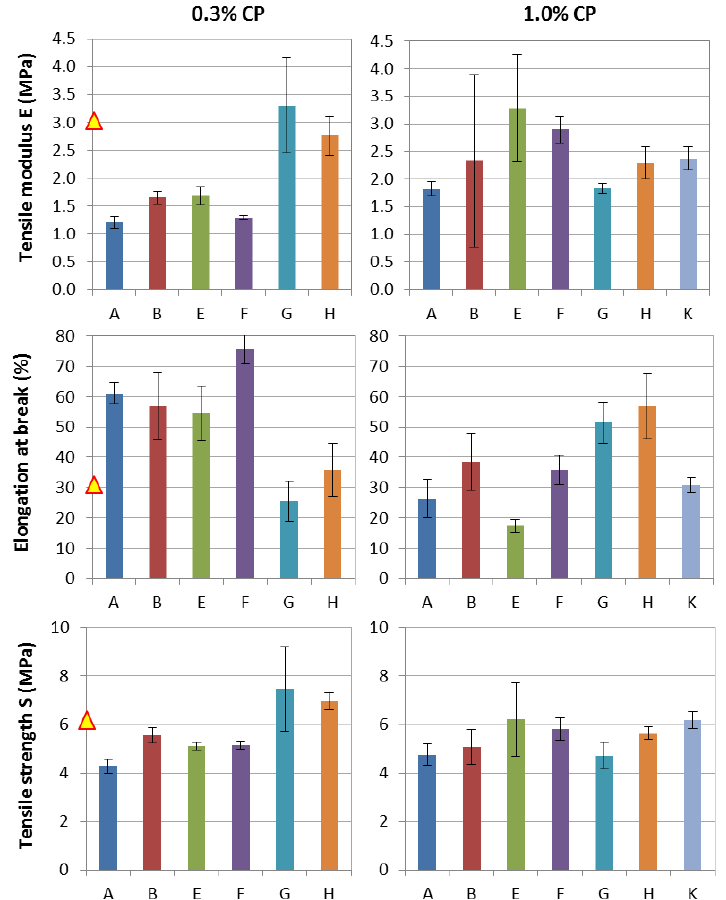
Figure 3. Tensile properties for different film formulations containing 0.3% or 1.0% pectin, measured at 54%–58% RH, for film thicknesses d = 0.035–0.05 mm.